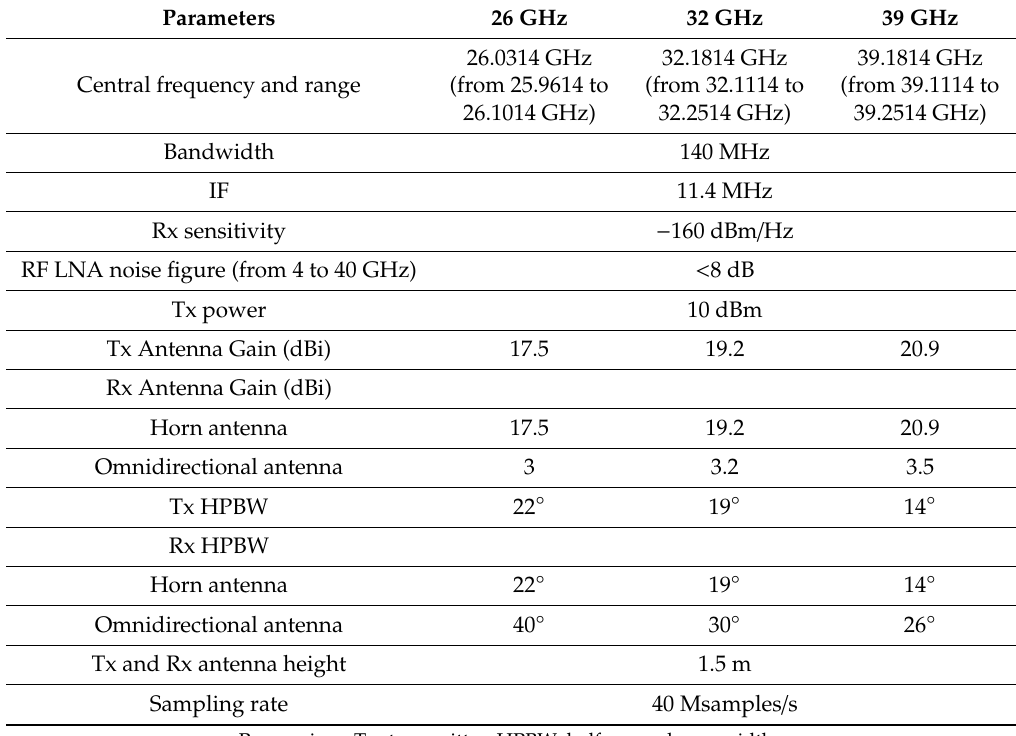
Table 1. Main parameter values at the three